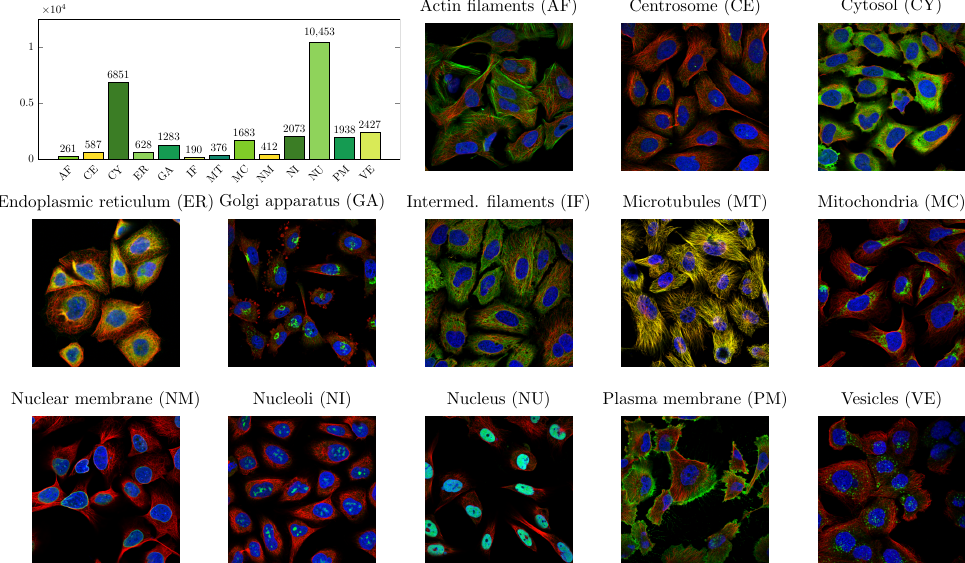
Figure 1. Cell organelle distributions (graph) in the dataset reveals imbalance between phenotype classes. Color coding is for visual separation of the bars. Example images of each cell organelle, written in image titles, show characteristic localization pattern of each phenotype. Blue color channel shows the nucleus and red channel presents microtubules. Green channel presents the protein of interest, labeled with immunofluorescence. Yellow reference color channel showing endoplastic reticulum was not used in images, however, green and red channels in same locations result in yellow color. This is especially clear in microtubules image, where both red and green colors mark